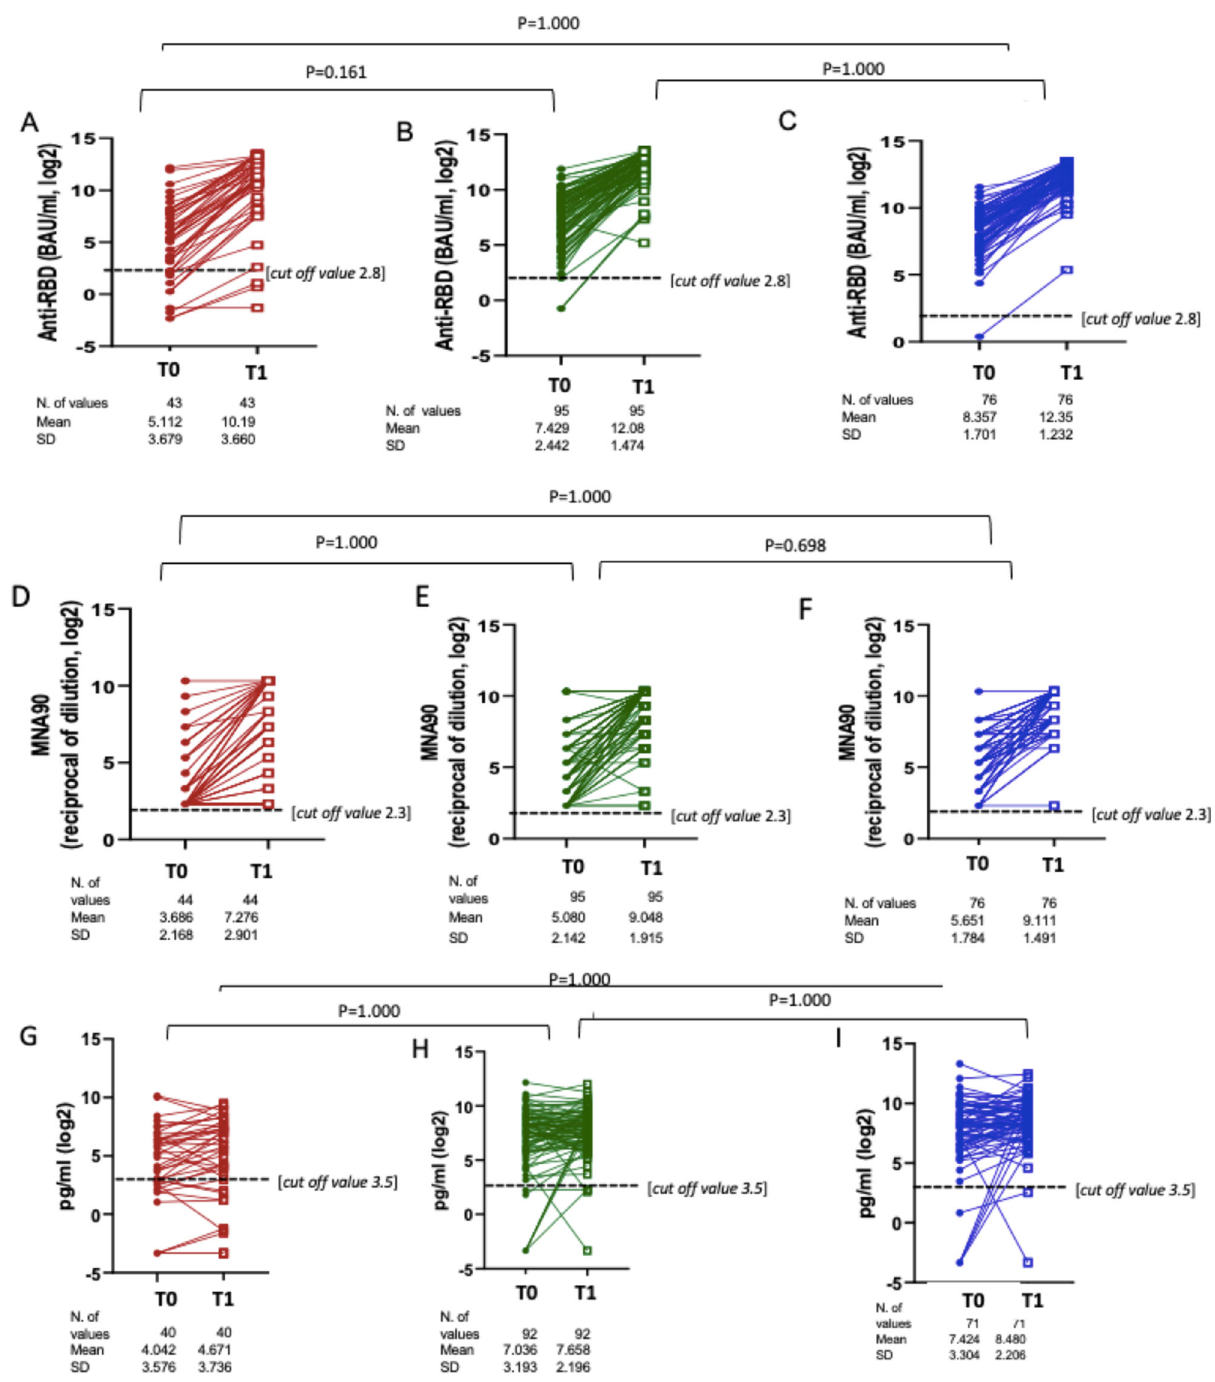
Fig. 4 | Changes of anti-RBD IgG, MNA 90 and IFN- γ from T0 to T1 in PLWH according to immunode fi ciency status. A − C Log 2 change of anti-RBD IgG from T0 to T1 according to immunode fi ciency status: PCDR ( A ), ICDR ( B ), HCDR ( C ). D − F Log 2 increase of nAbs (MNA 90 ) from T0to T1according to immunode fi ciency status: PCDR ( D ), ICDR ( E ), HCDR ( F ). G − I Log 2 increase of IFN- γ from T0 to T1 according to immunode fi ciency status: PCDR ( G ), ICDR ( H ), HCDR ( I ) (ANOVA, 2-sided with Bonferroni adjusted p -values for multiple comparisons). Red dots representmeanvaluesofantiRBDIgG,MNA90andIFN- γ beforethethirddose,red